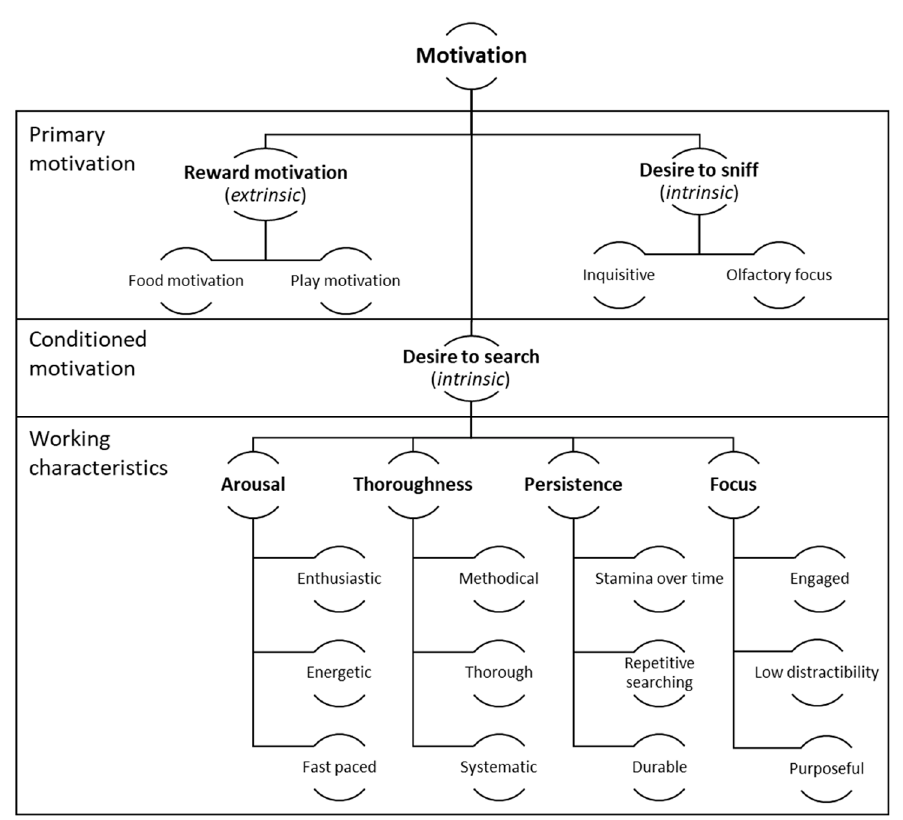
Figure 1. Characteristics and descriptors associated with work motivation among biosecurity detector dogs, as described by focus group participants.